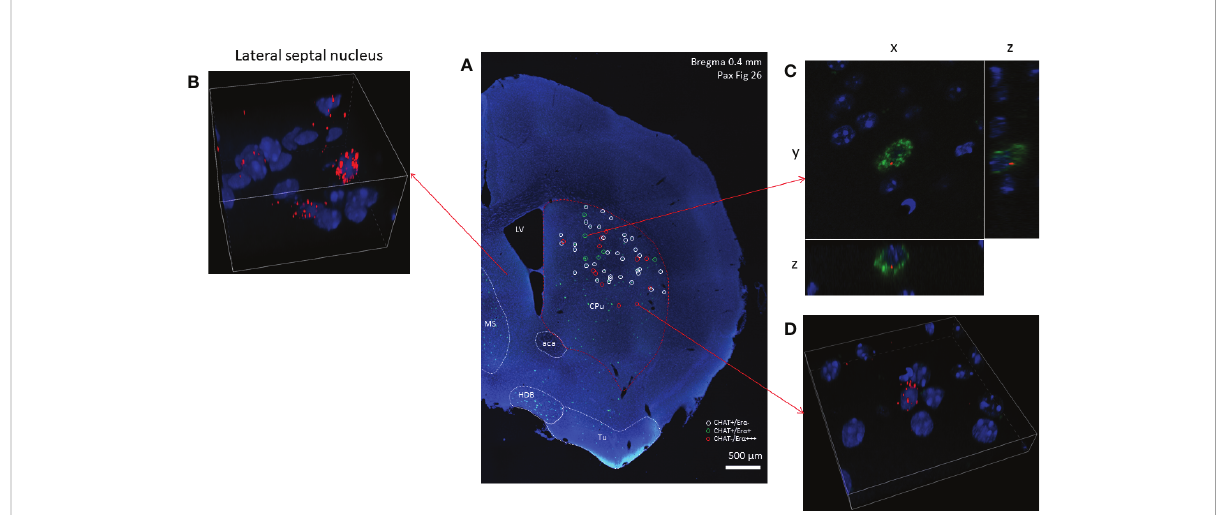
FIGURE 3 Estrogen receptor alpha mRNA expression in striatal cholinergic neurons. Overview image of the right side of a coronal section obtained from an adult male mouse brain is presented in Panel (A) (10x). Green fl uorescence labeling show cholinergic cells expressing CHAT mRNA (Panel A ). White and green circles mark ER a -negative and ER a -positive striatal cholinergic neurons, respectively. Non-cholinergic cells with strong ER a positivity are highlighted with red circles. Cells expressing ER a at high level in the lateral septum are depicted in Panel (B) (60x). A representative ER a -positive striatal cholinergic neuron is shown in Panel (C) (blue: nuclei, green: CHAT mRNA, red: ER a mRNA, 60x). In Panel (D) , one non- cholinergic cell with abundant expression of ER a mRNA is presented (60x). CPu, caudate-putamen; aca, anterior limb of anterior commissure; MS, medial septum; HDB, horizontal limb of the diagonal band of Broca; Tu, olfactory tubercle; LV, lateral ventricle.